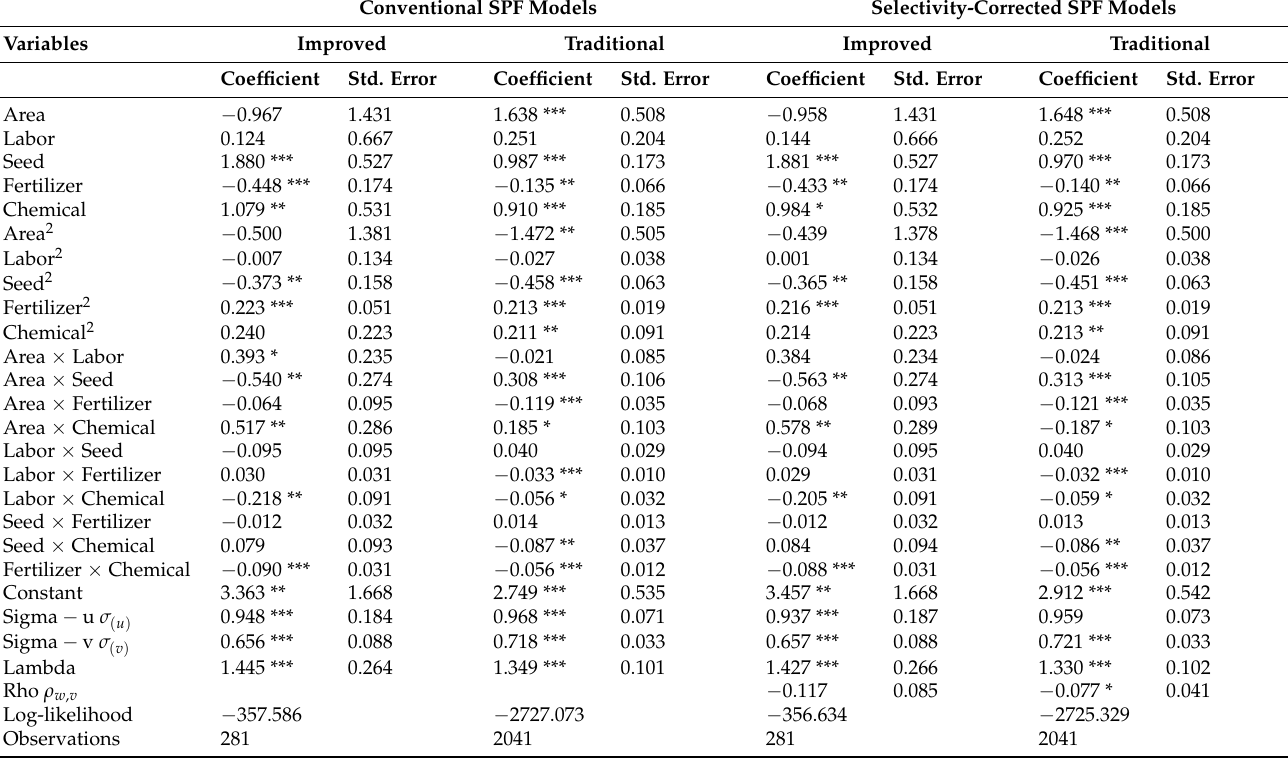
Table 5. Maximum likelihood estimate of the conventional and selectivity-corrected SPF models using matching